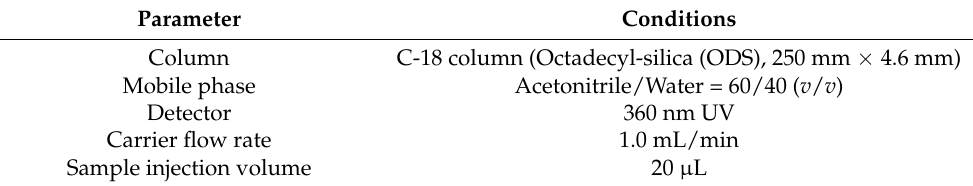
Table 3. High-performance liquid chromatography (HPLC) analysis